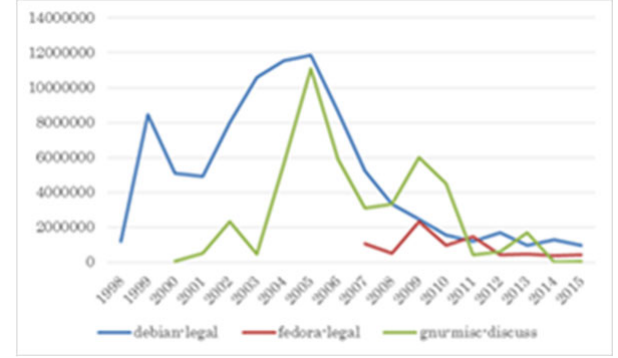
Figure 1. The flow of the amount of mailing lists (unit: bytes) Source: Drafted by